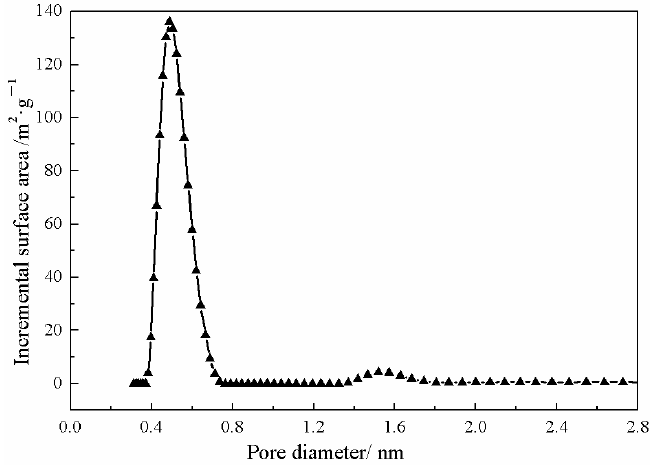
Membranes 2023 , 13 , x FOR PEER REVIEW Figure 2. Particle size distribution of ZIF-67. Figure 2. Particle size distribution of ZIF-67. Figure 2. Particle size distribution of ZIF-67.